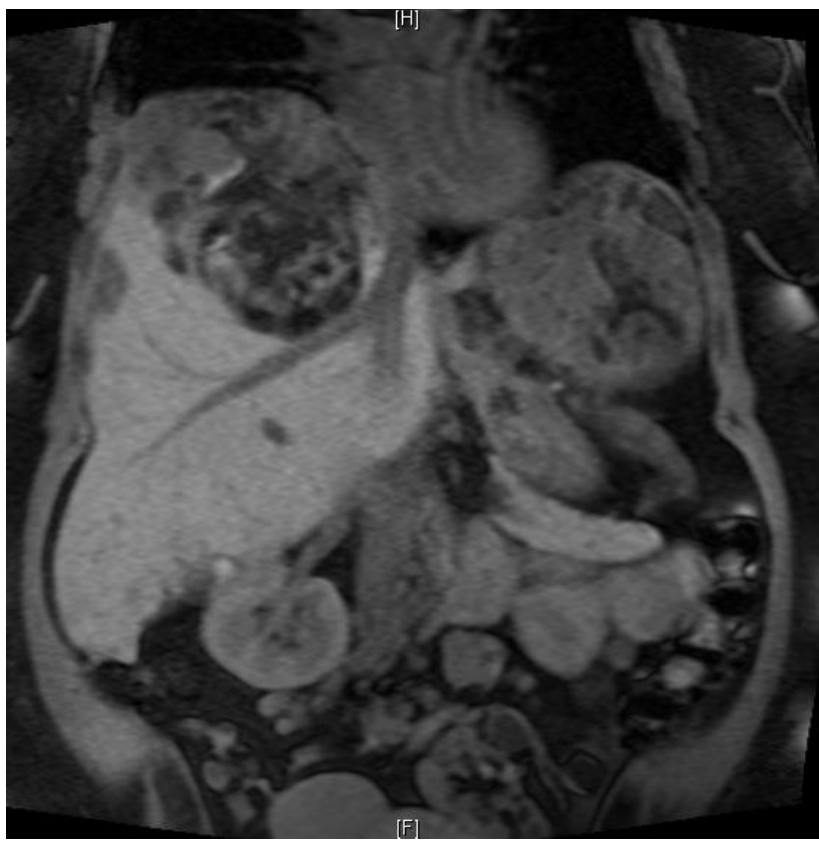
FIGURE 3. Magnetic resonance imaging of the abdomen performed 10 months prior to the study seen in Figs. 1 and 2. No homogeneous mass suggestive of the later-discovered sarcoma is